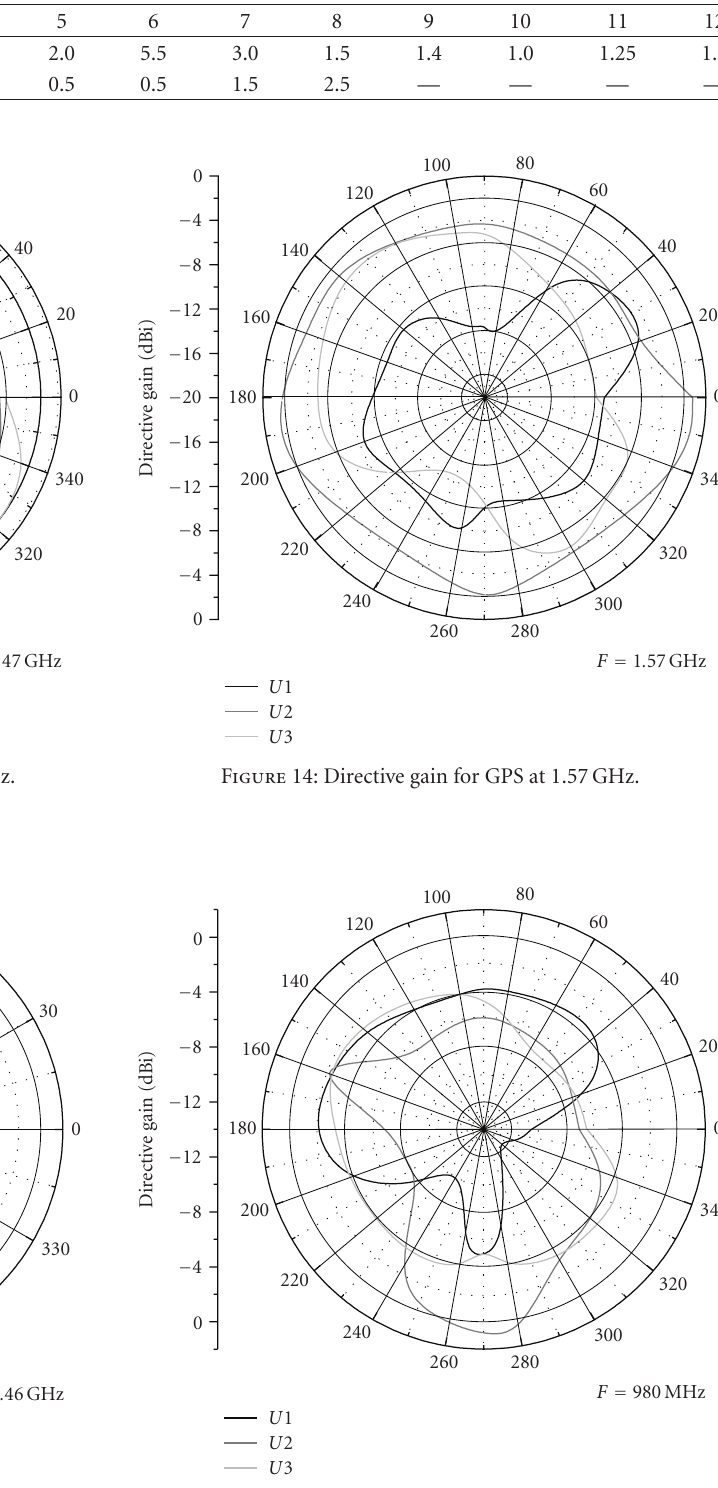
Figure 13: Directive gain for WLAN at 2.45 GHz.